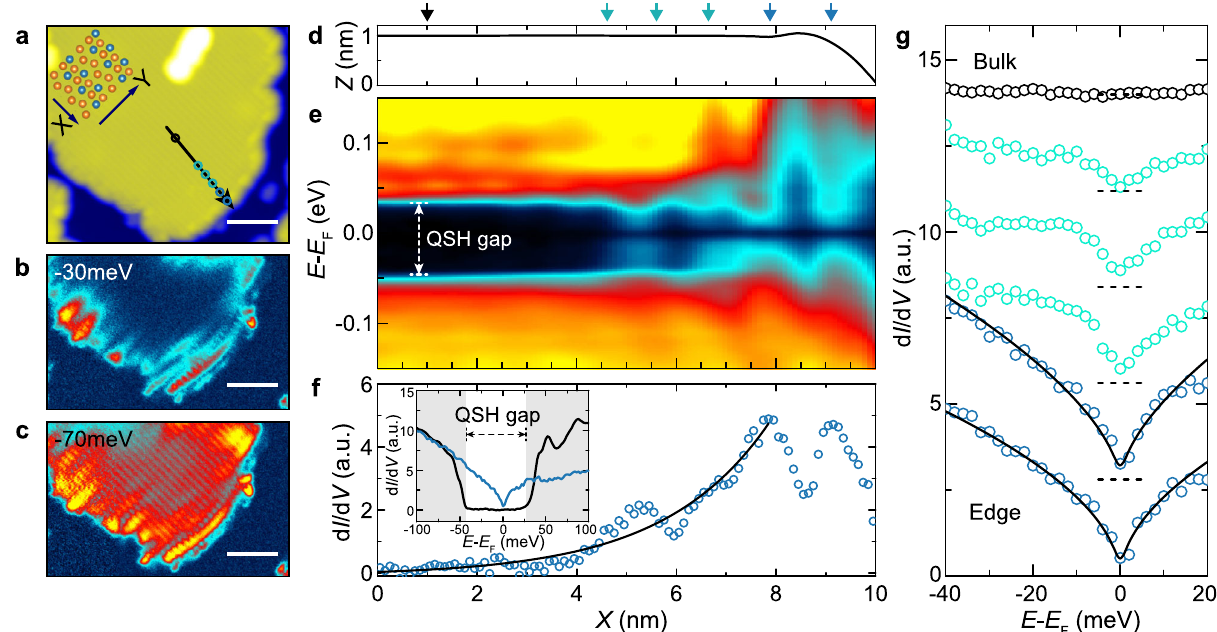
Fig. 1 | Edge states in monolayer 1T ’ -WTe 2 . a STM topograph ofa monolayer 1T'- WTe 2 crystal (scale bar: 5 nm). Insert: Crystal structure of the 1T'-WTe 2 crystal structure with W atoms (blue) and Te atoms (orange). Arrows represent different edge terminations. b , c Corresponding differential conductance (d I /d V ) maps of thesameislandasin a ,measuredinconstantheightmode. d – f Spatialpro fi leofthe measured local density of state (LDOS) at 4.5 K, across the monolayer edge along the blackarrow in a , and comparedto acorresponding STM height pro fi le ( d ).We